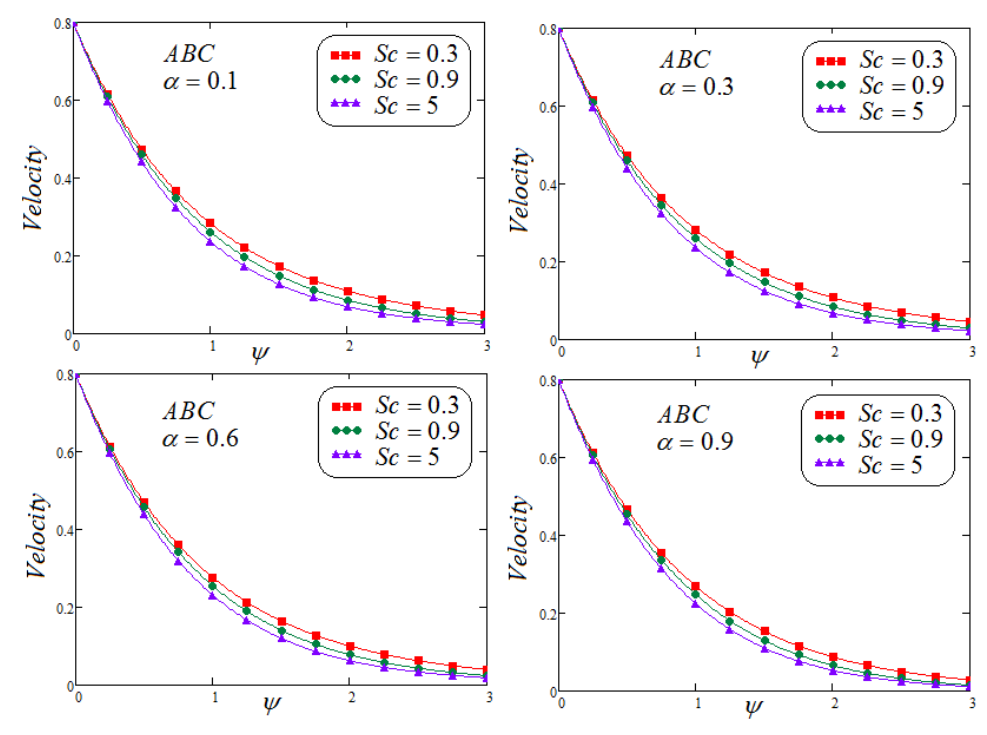
Figure 6. Trace of dimensionless velocity for dissimilar values of Sc via